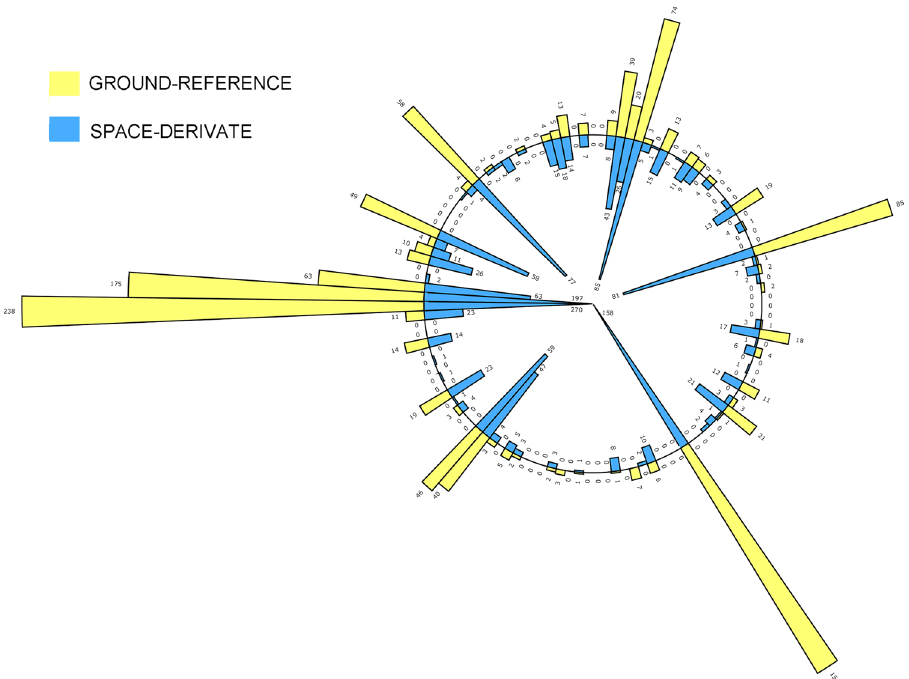
Figure 2. Circular bar plots showing of single nucleotide variants (SNVs) in the ground-reference Chroococcidiopsis sp. CCMEE 029 and space-derivate. The yellow bar plot shows the SNV frequency in the ground-reference genome representing the sum, according to the set theory, of the SNVs of each ground- reference replicate (CCMEE 029 A, B and C). The light-blue bar plot shows SNVs frequency in the space- derived genome. Bars indicate the SNVs frequency in 50-kbp sectors, numbers show absolute frequency